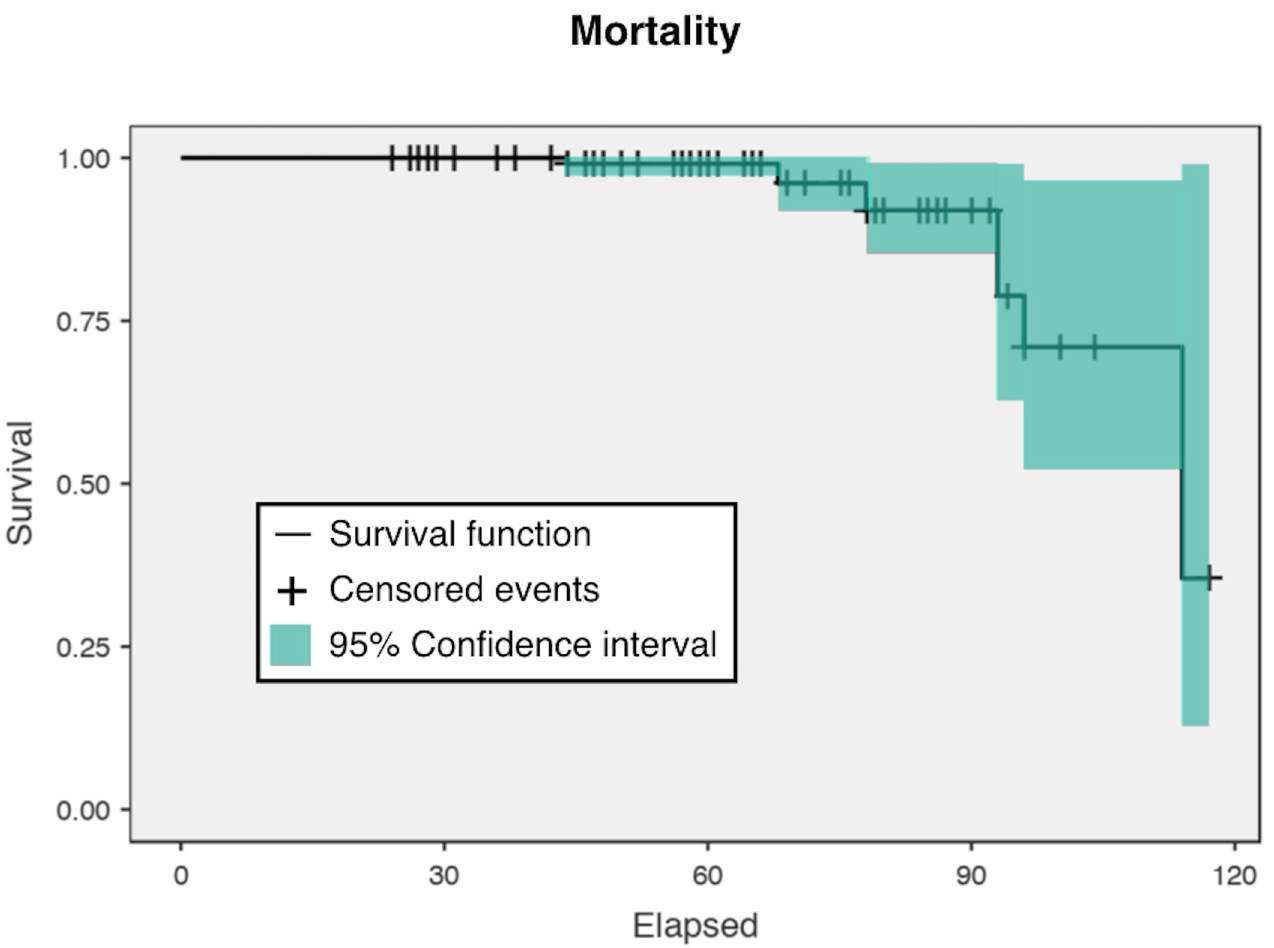
Fig 4. Kaplan-Meier survival function for mortality in patients (n = 148) treated with two-stage revision. The 95% confidence interval is shown in green.